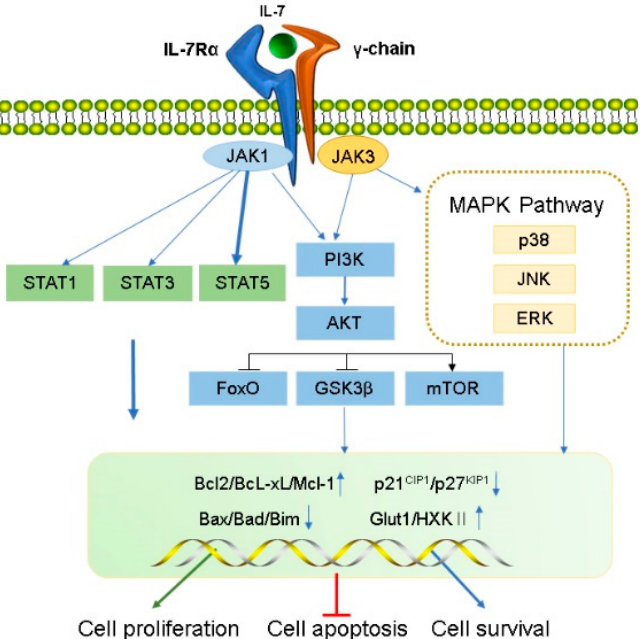
Figure 1. Transduction of IL-7 signaling pathway. IL-7 induces the activation of IL-7R downstream signaling pathway kinases, including JAK1 (linked to IL-7R α ) and JAK3 (linked to common γ C), STAT1, STAT3, STAT5, PI3K, AKT, and MAPK. IL-7 signal transduction promotes cell proliferation and survival and inhibits apoptosis by regulating gene expression levels in the nucleus, including a decrease in pro-apoptotic factors (such as Bad and Bax) and cell cycle inhibitors (p21 CIP1 and p27 KIP1 ) and an increase in anti-apoptotic factors (such as Bcl-XL, Bcl-2, and McL-1) and glucose metabolism regulators (Glut1, HXK Ⅱ ).